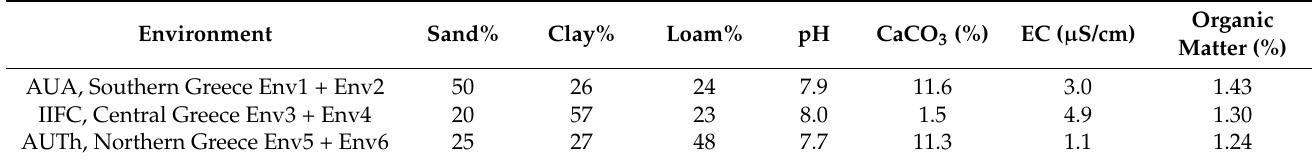
Table 1. Soil features of the fields in the three experimental